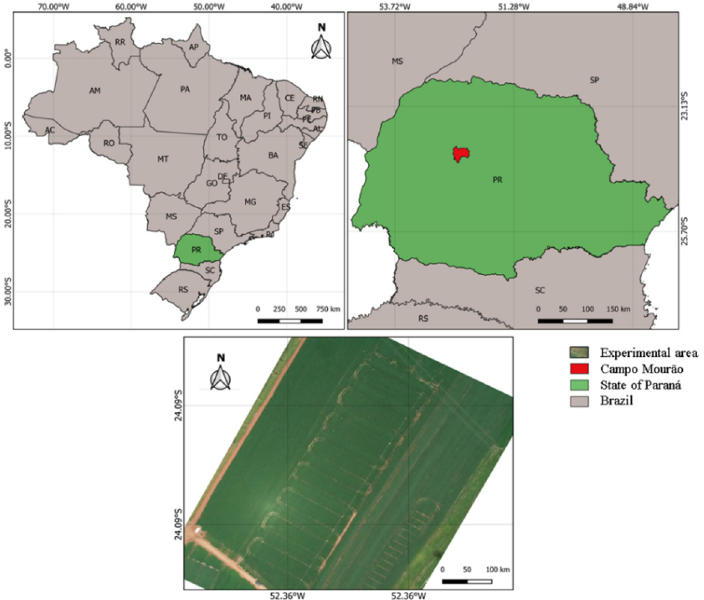
Figure 1. Location of the experimental area in the municipality of Campo Mourão, State of Paraná,